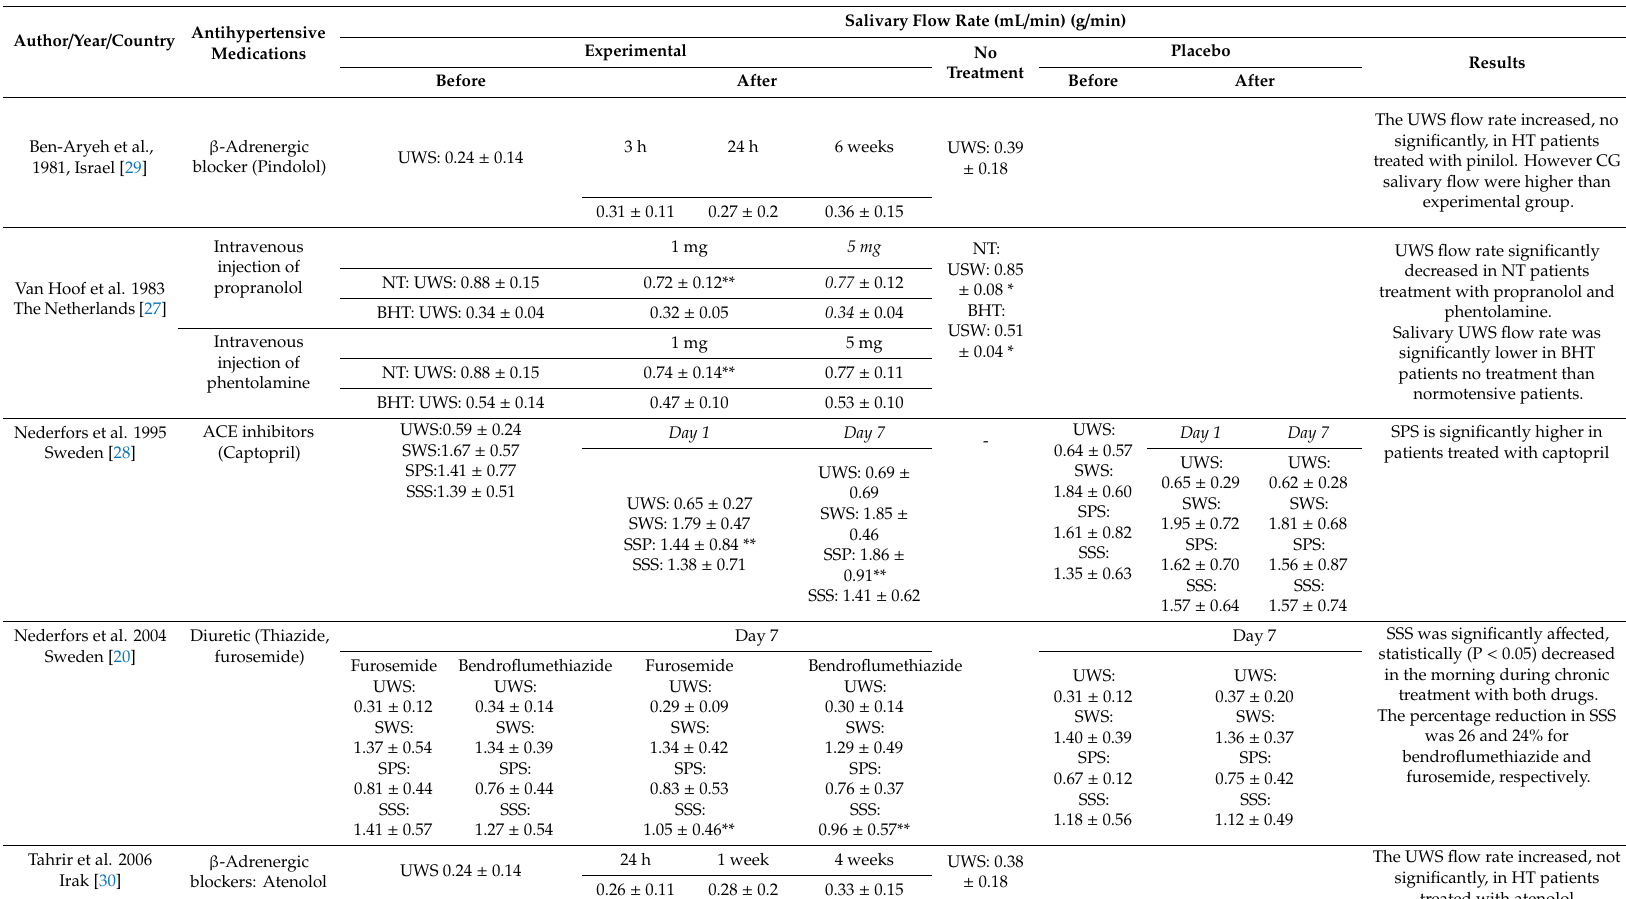
Table 4. Clinical trials